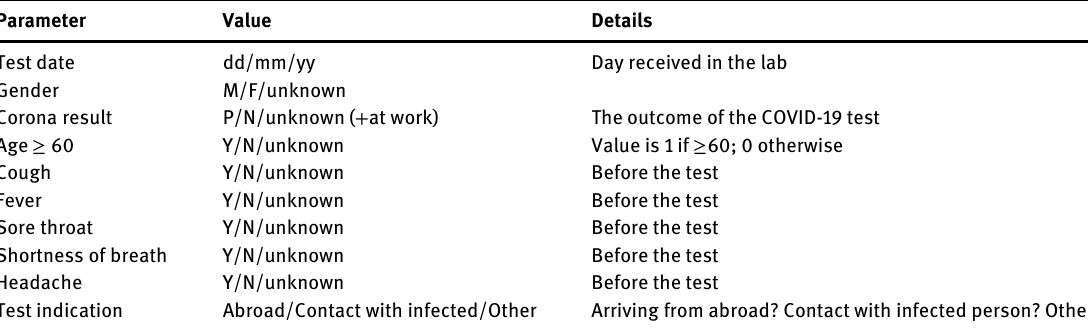
Table 1: Immediate clinical features recorded for people sampled for viral DNA in Israel.